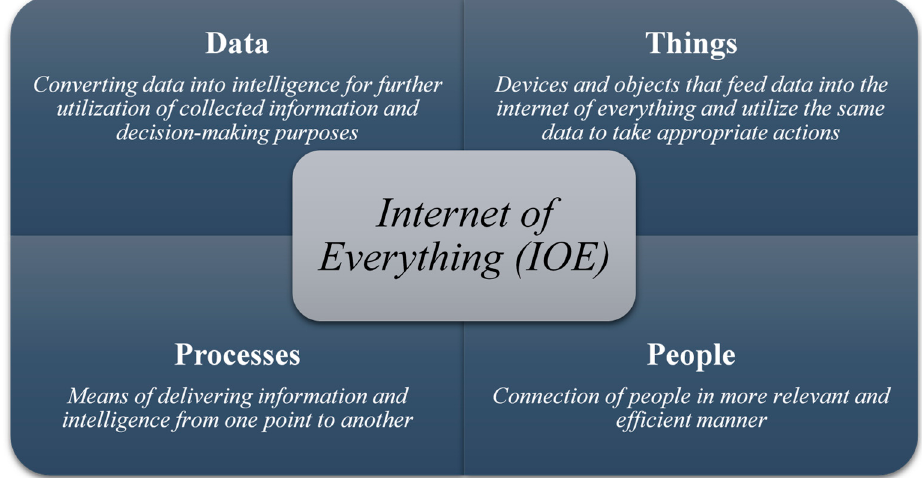
Figure 3. Categories of Internet of Everything (IOE).